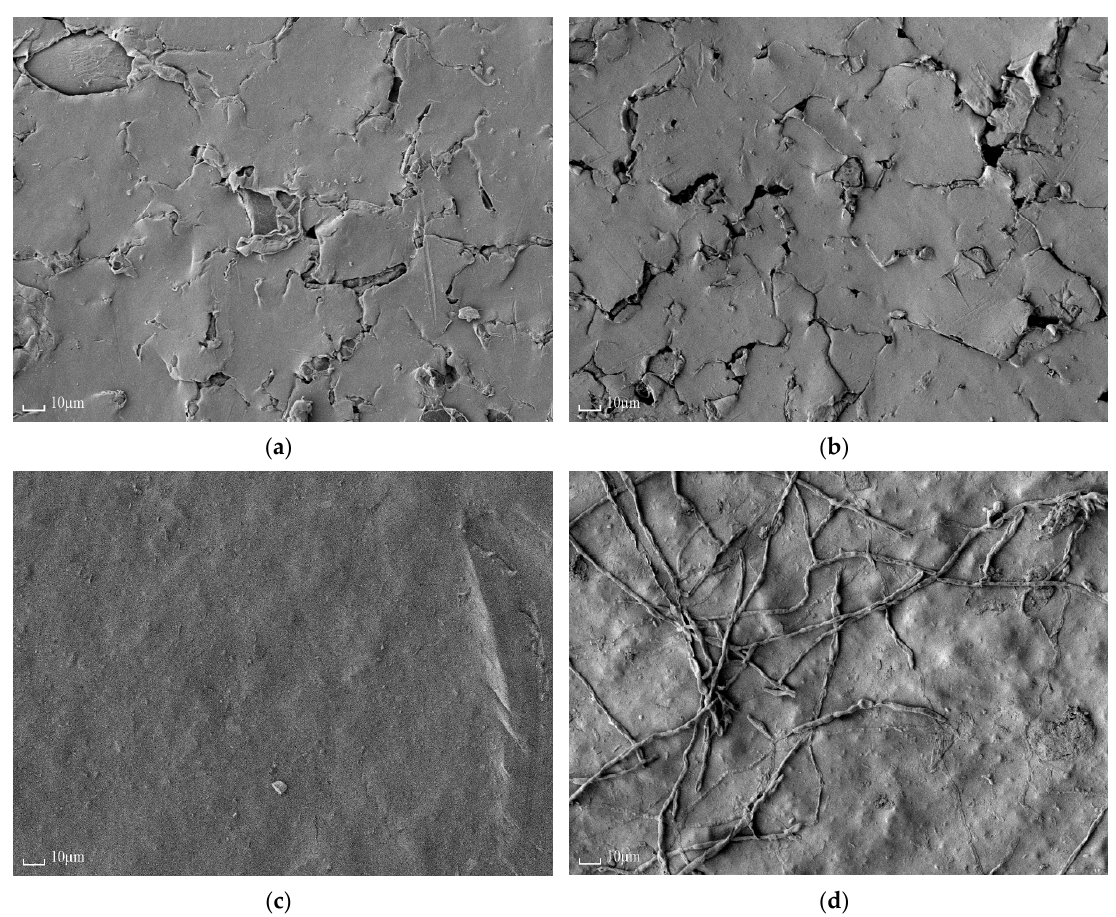
Figure 8. SEM images of the non-modified ( a , c ) and modified ( b , d ) surfaces of the MK-40/PANI ( a , b ) and MF-4SK/PANI ( c , d ) membranes.